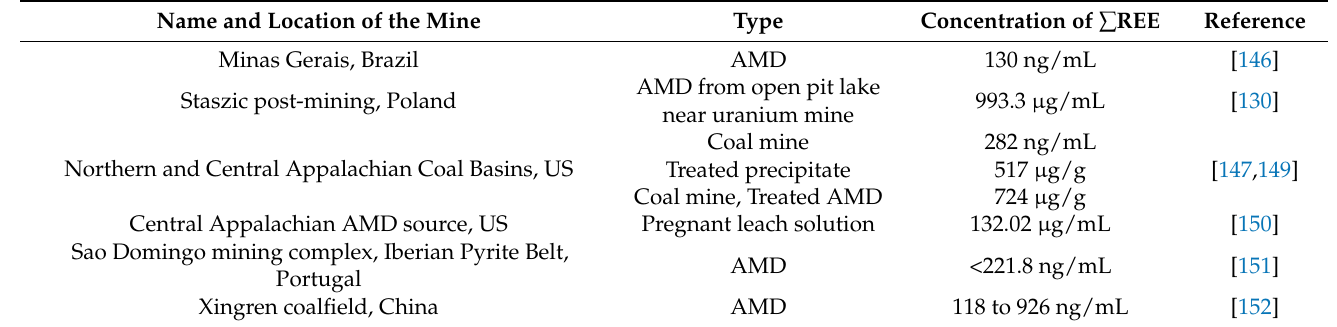
Table 7. Concentrations of REE in acid mine drainage (AMD) from different mines across the globe. Name and Location of the Mine Type Concentration of ∑